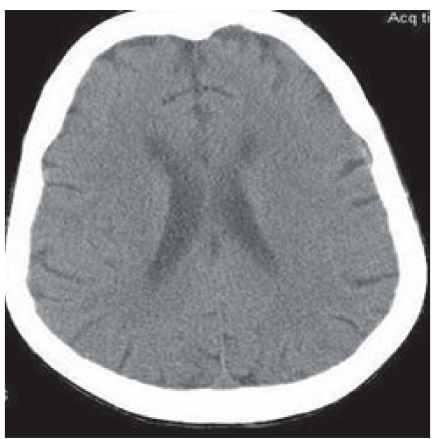
Figure 2: CT scan of head without any intracranial lesion.